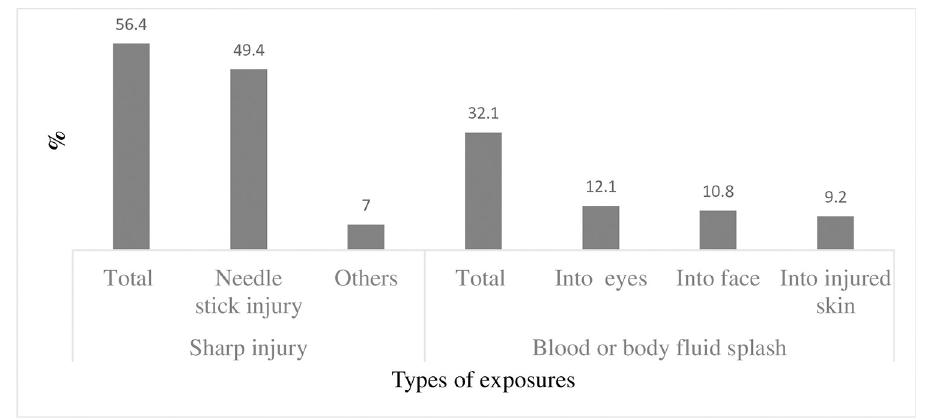
Fig 1. Types of occupational exposure to hepatitis C virus infection among health care